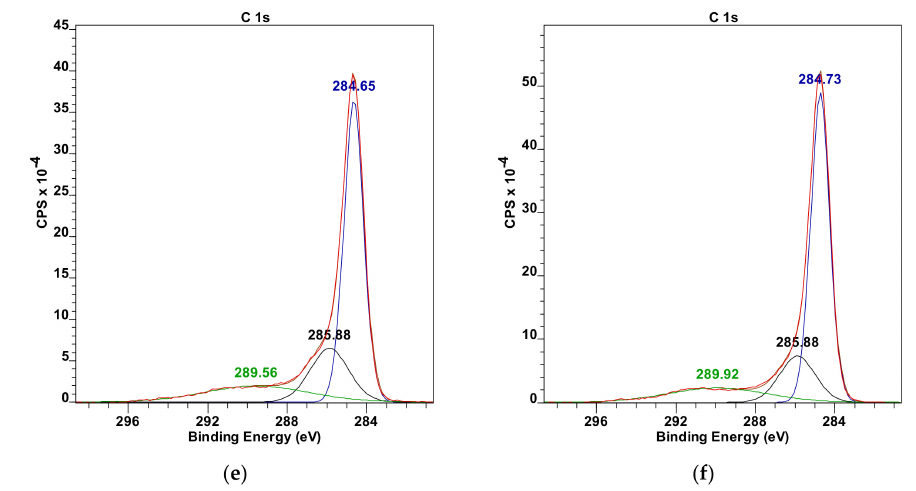
Figure 7. Collection of deconvoluted XPS C 1s spectra for ( a ) C-S 1 GO, ( b ) C-S 2 GO, ( c ) C-S 3 GO,